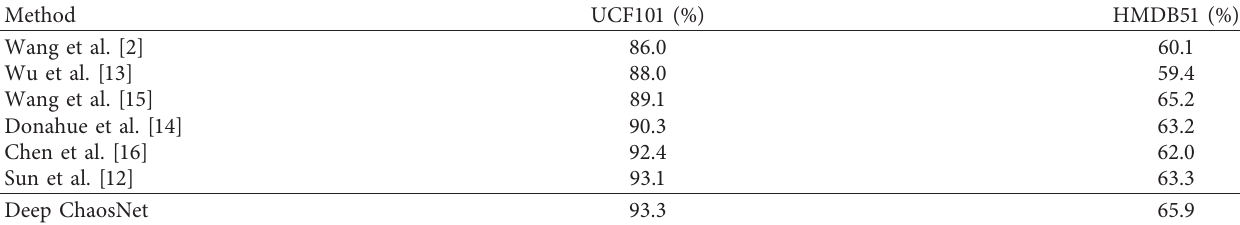
Table 1: Comparison of the proposed method with the state-of-the-art approaches.